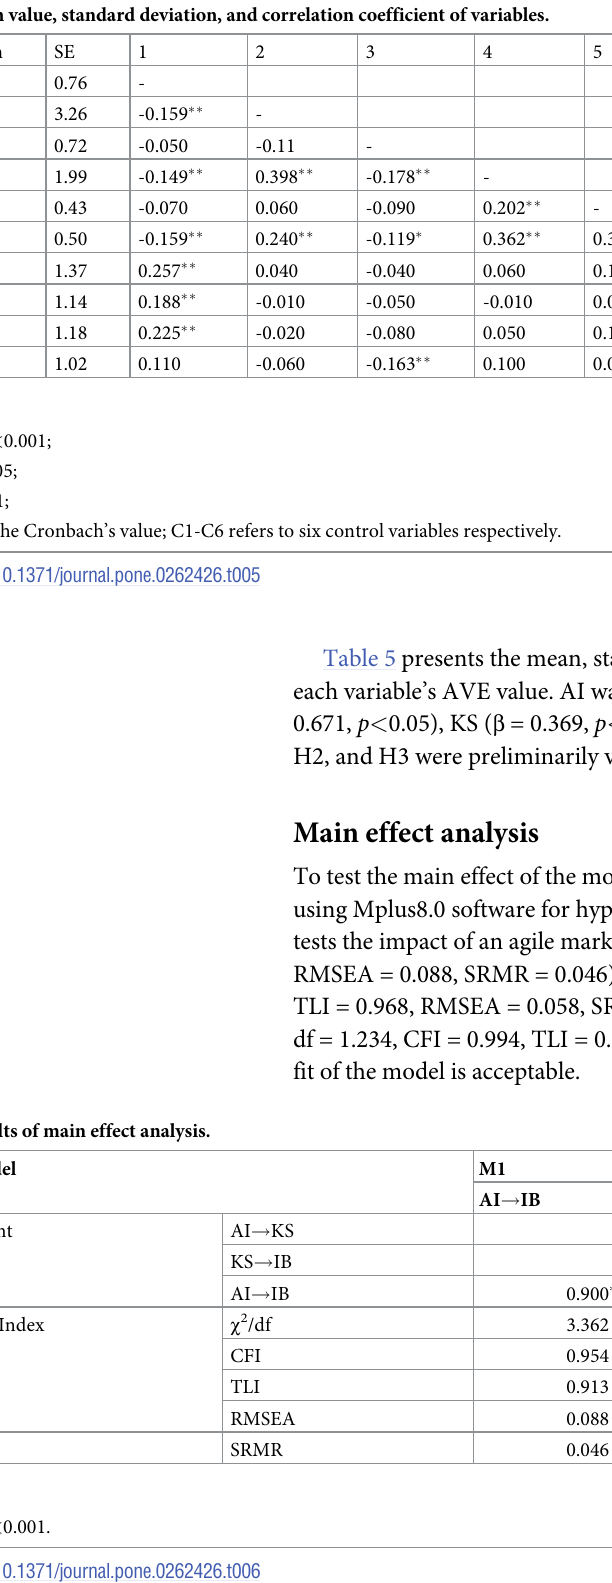
Table 5. Mean value, standard deviation, and correlation coefficient of variables.